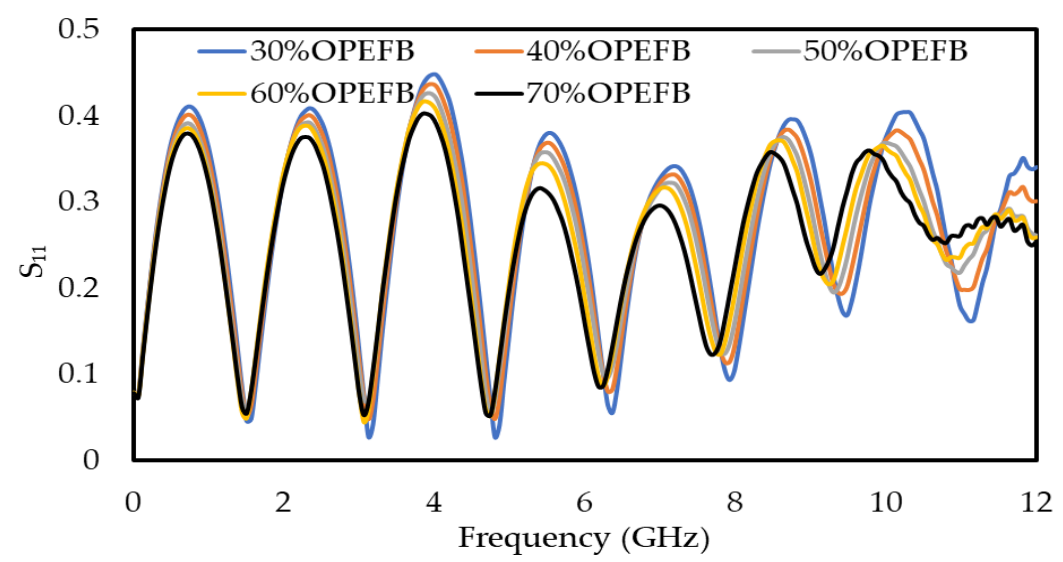
Figure 6. Variation of reflection (S 11 ) for OPEFB/PLA composite at different percentages of OPEFB.